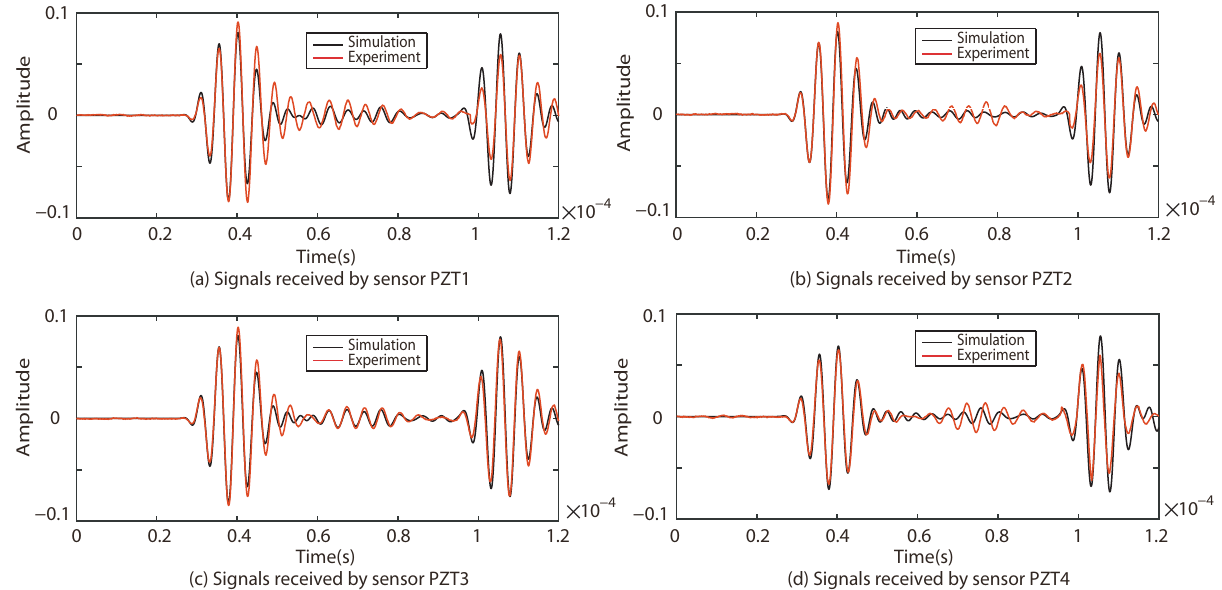
Figure 16. Comparison of experimental and simulation results under the center frequency of 200